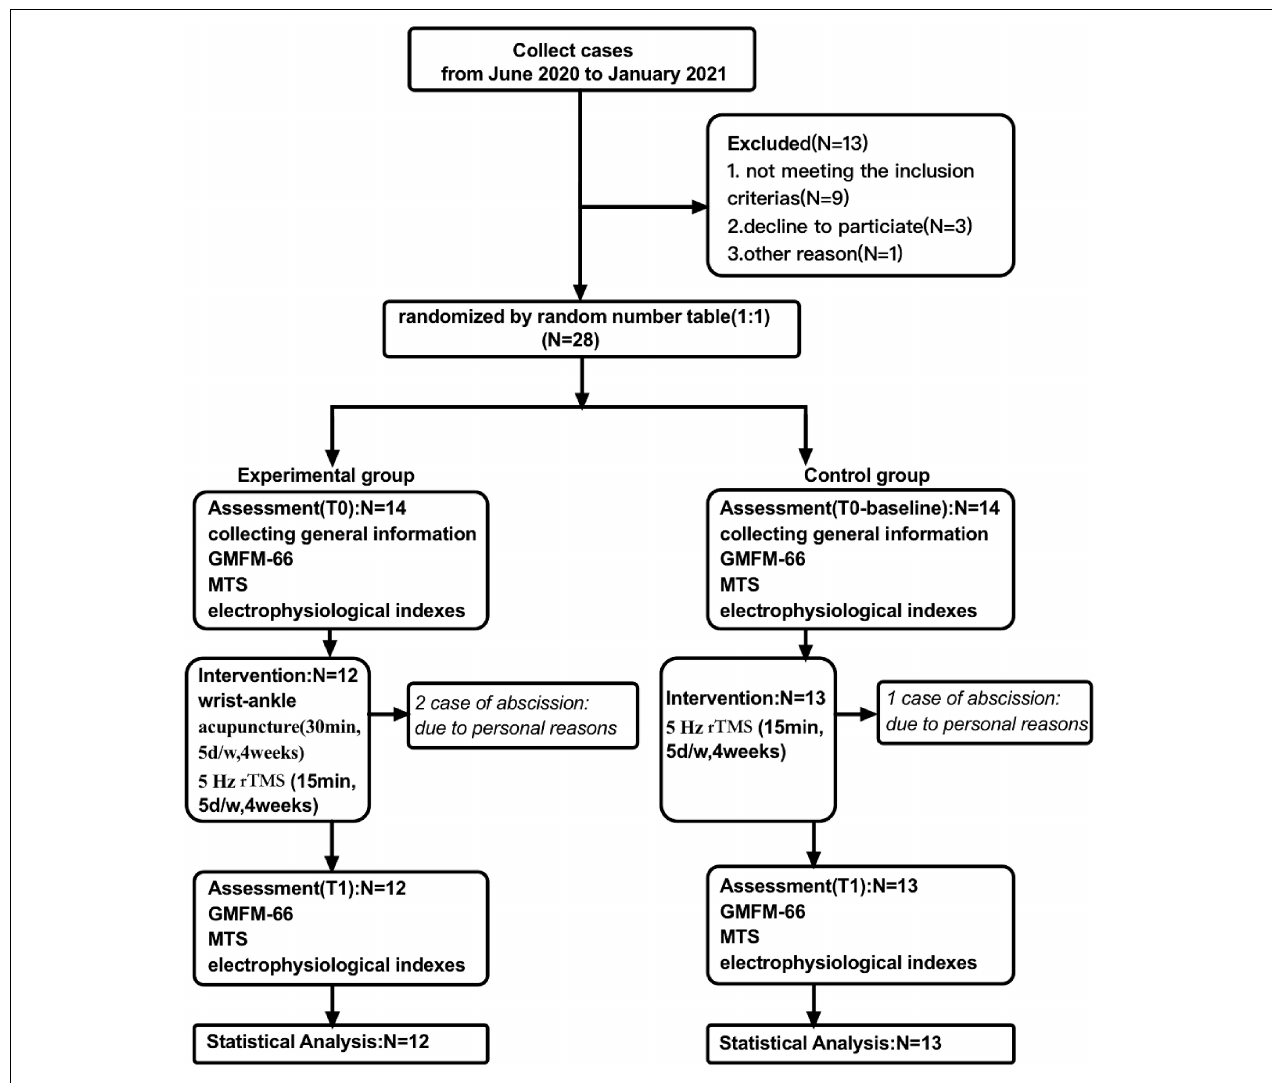
FIGURE 1 | Study design flow